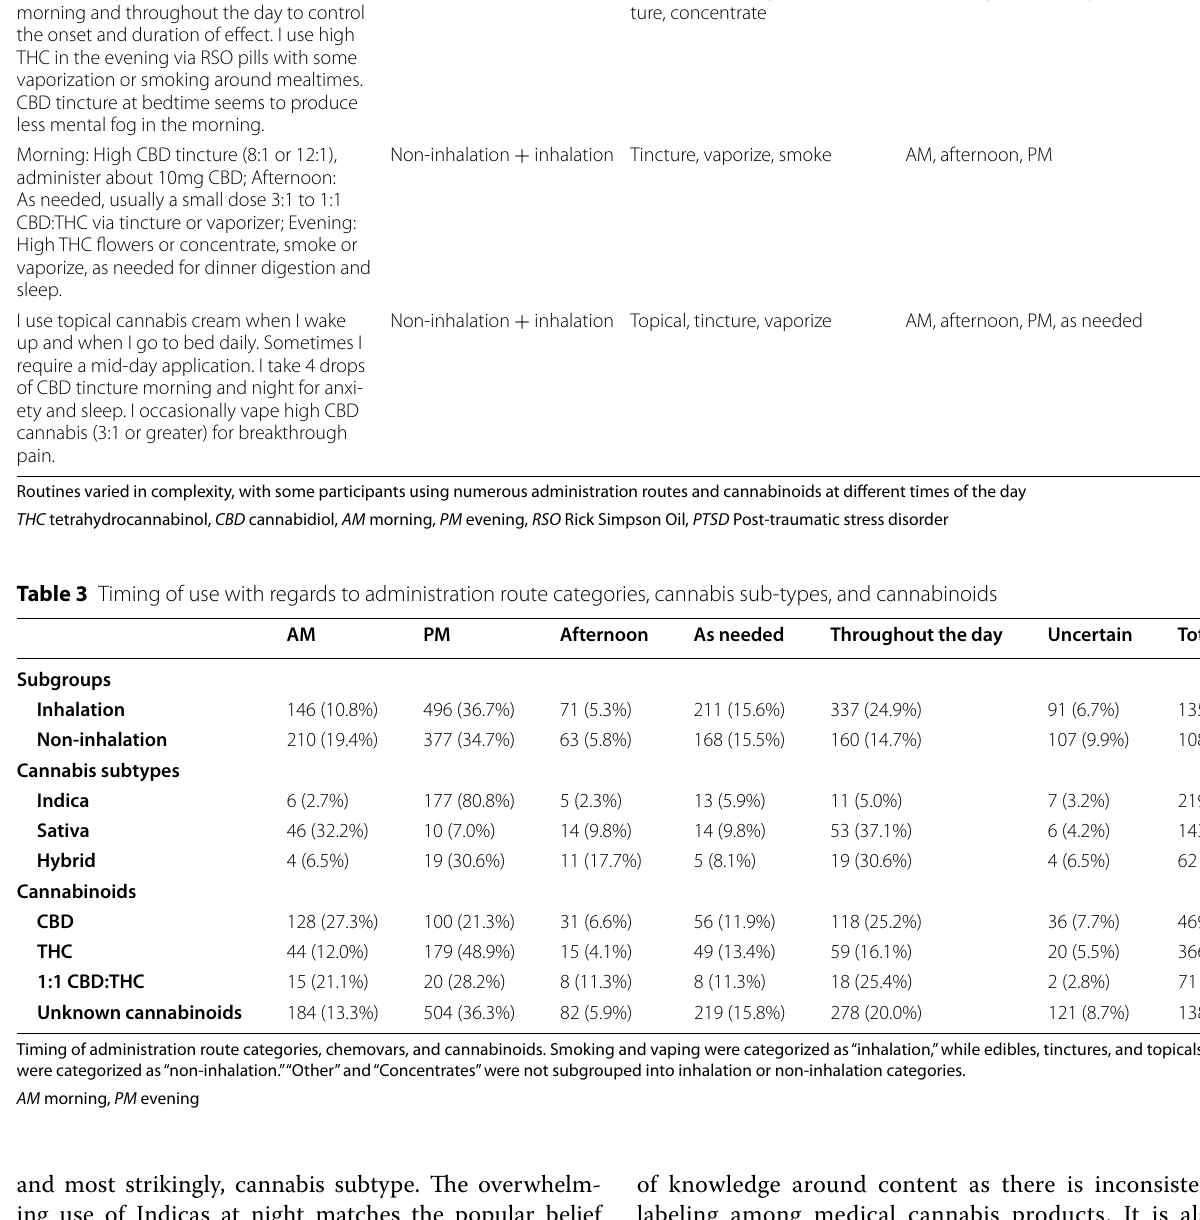
Timing of administration route categories, chemovars, and cannabinoids. Smoking and vaping were categorized as “inhalation,” while edibles, tinctures, and topicals were categorized as “non-inhalation.” “Other” and “Concentrates” were not subgrouped into inhalation or non-inhalation